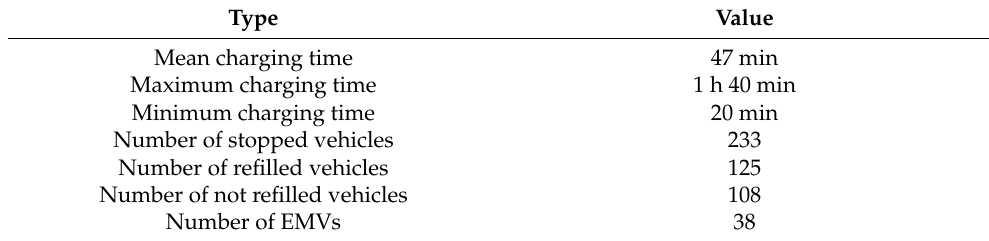
Table 2. Simulation results synthesis. Type